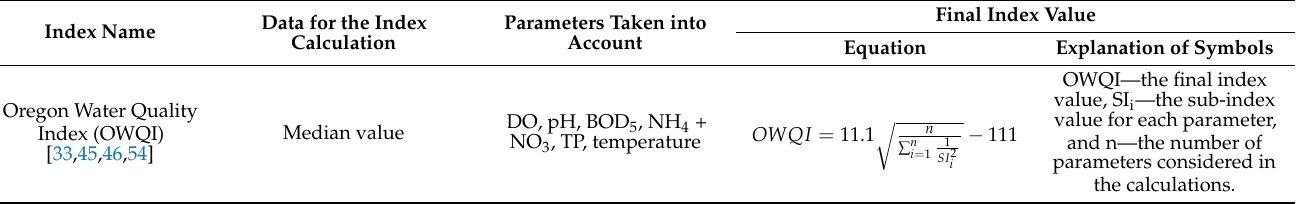
Table 6. Basic information on determining the water quality indexes described in the article (OWQI, OIP, DWQI, CPCB WQI, UWQI, and NSF WQI)—equations converted to a scale of index values from 0 to 100 points